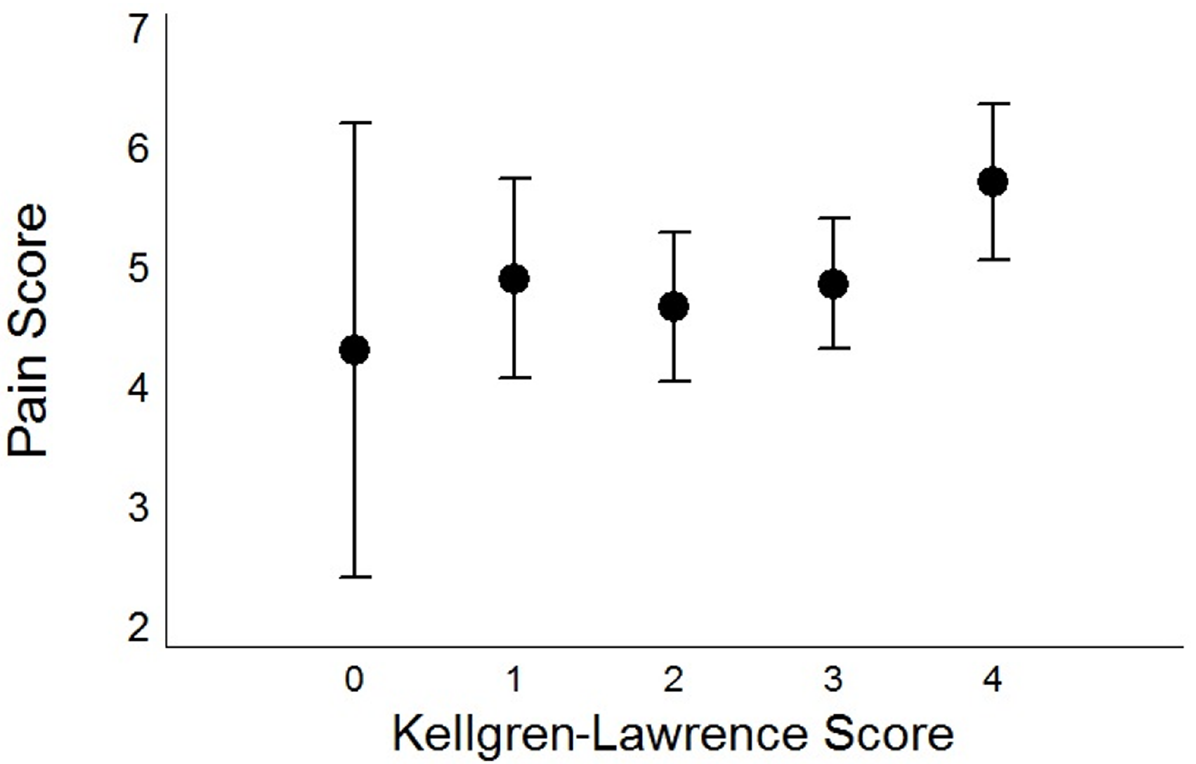
Fig 2. Kellgren-Lawrence grade and pain scores. Mean knee-pain scores in 355 patients with knee osteoarthritis, according to Kellgren-Lawrence Grade. The error bars represent 95% confidence intervals adjusted by using the Tukey procedure for multiple comparisons. There were no significant differences between